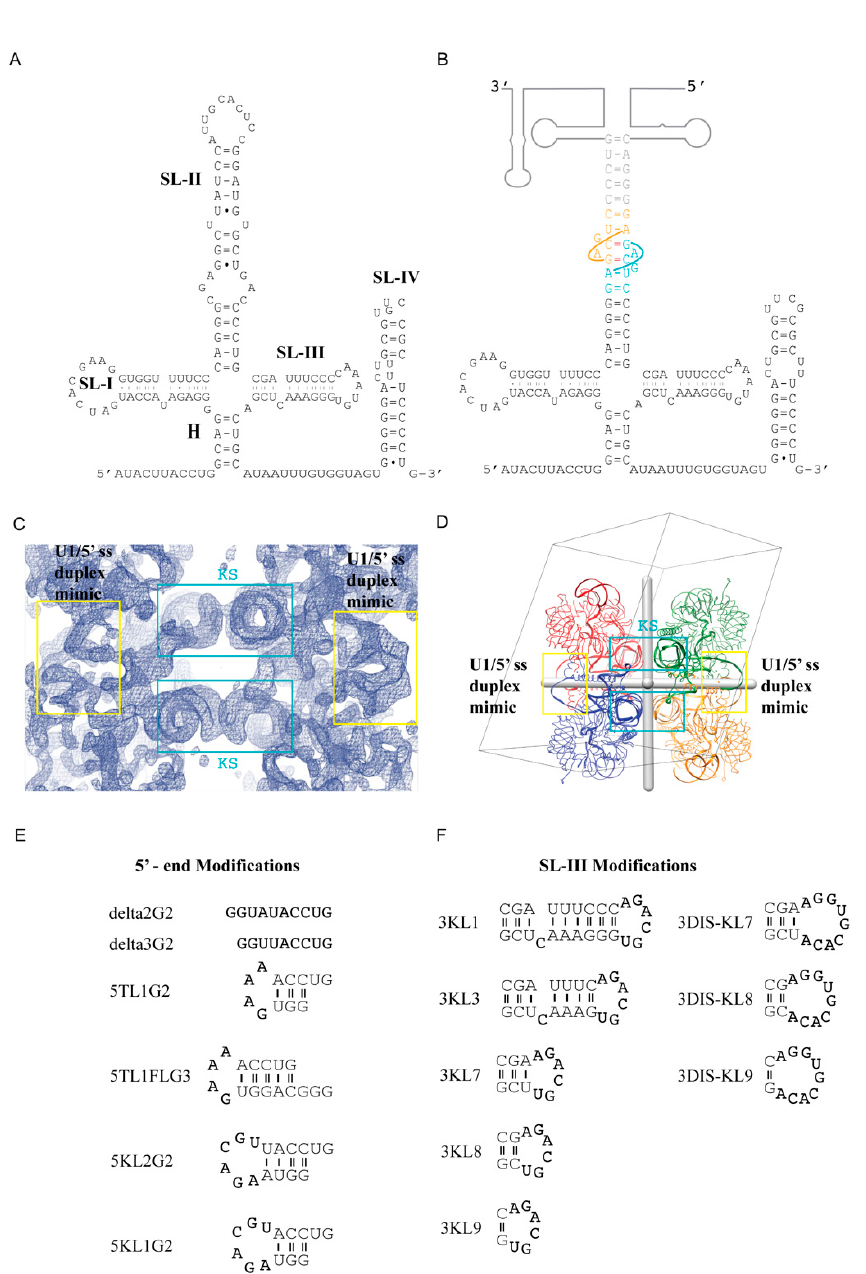
Figure 5. ( A ) Native sequence of U1 snRNA. ( B ) Construct used to crystallize the first U1 snRNP. The base pairing between the kissing loop is depicted in cyan and orange. ( C ) Experimental electron density map of U1 snRNP at 5.5 Å. Density for the major and minor grooves of the kissing loop helices and the U1/5 ′ ss helices is clear. ( D ) The packing arrangement of U1 snRNP for the P 1 crystal form (PDB:3CW1). The four NCS complexes are related by three orthogonal 2-fold symmetry axes (shown as gray rods). The kissing loop interactions are formed along one 2-fold. The 5 ′ strand of the U1 snRNA base pair with its NCS-related partner along another 2-fold axis, mimicking the U1/5 ′ ss interaction. ( E , F ) Summary of the next series of constructs modified to improve diffraction quality of the P 1 crystal form. Examples of constructs with modified 5 ′ end ( E ) and modified SL-III ( F ).